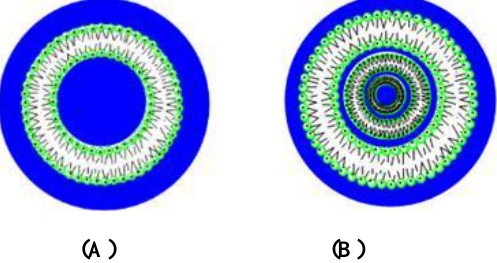
Figure 1. Structure of unilamellar ( A ) and multilamellar ( B ) liposomes.